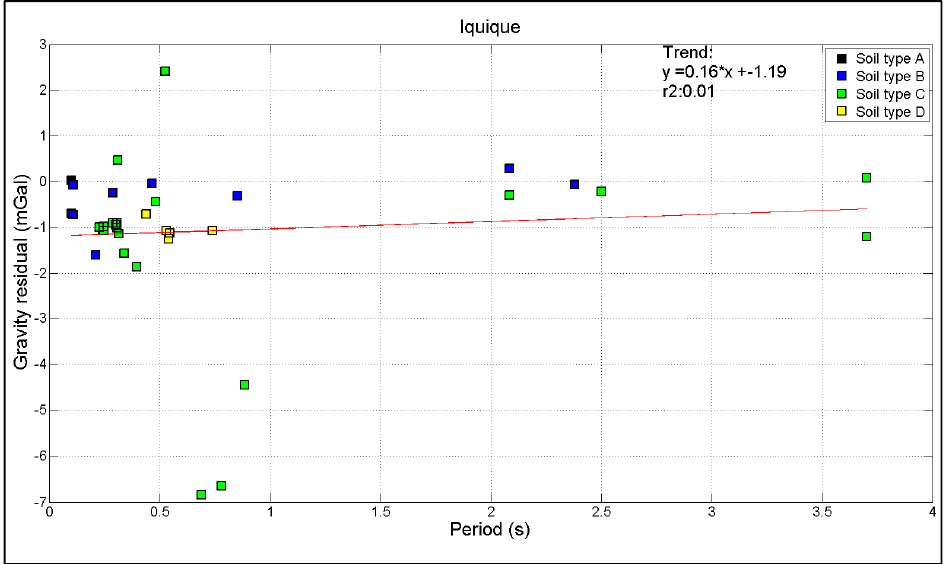
Figure 8. Correlation between gravity residuals and H/V predominant periods in Iquique. The colors represent the seismic classification of the sites according to Table 1.